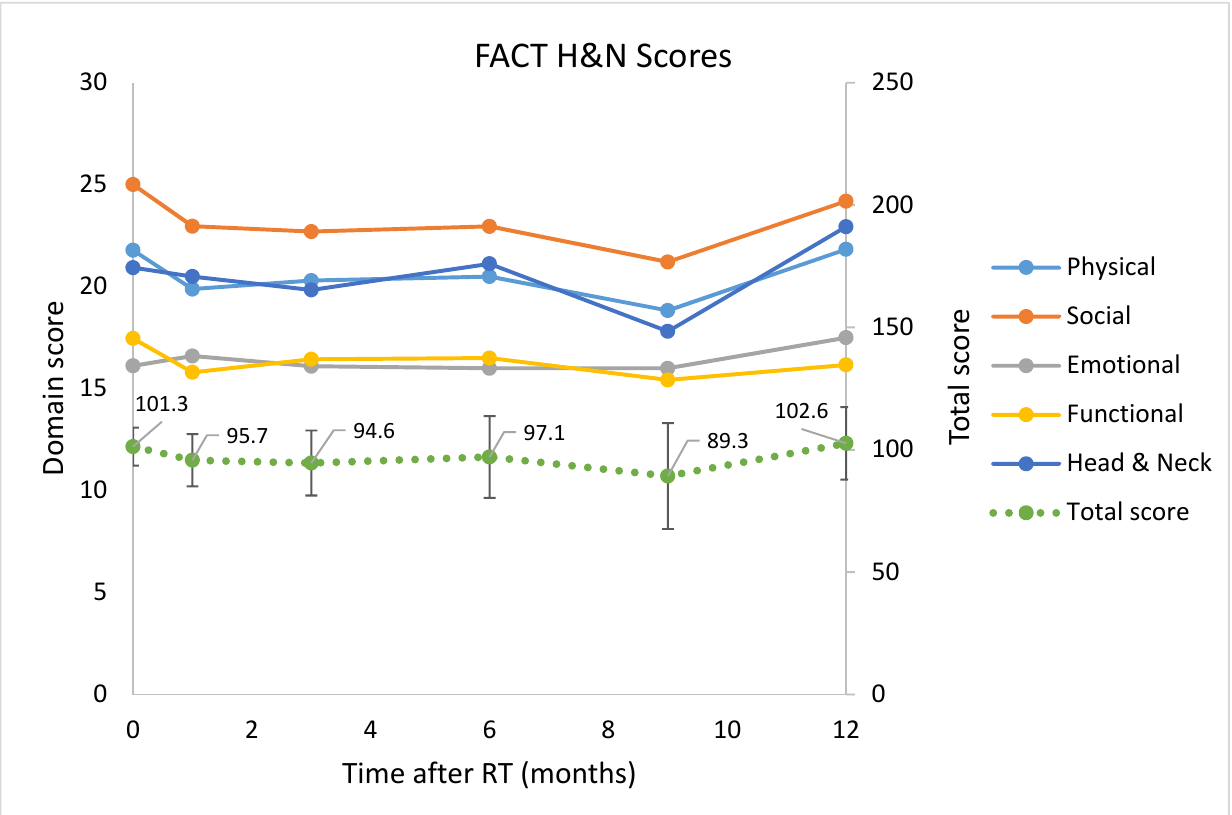
Figure 4. FACT H&N subdomain and total scores at baseline and at each follow-up time post-treat- ment.